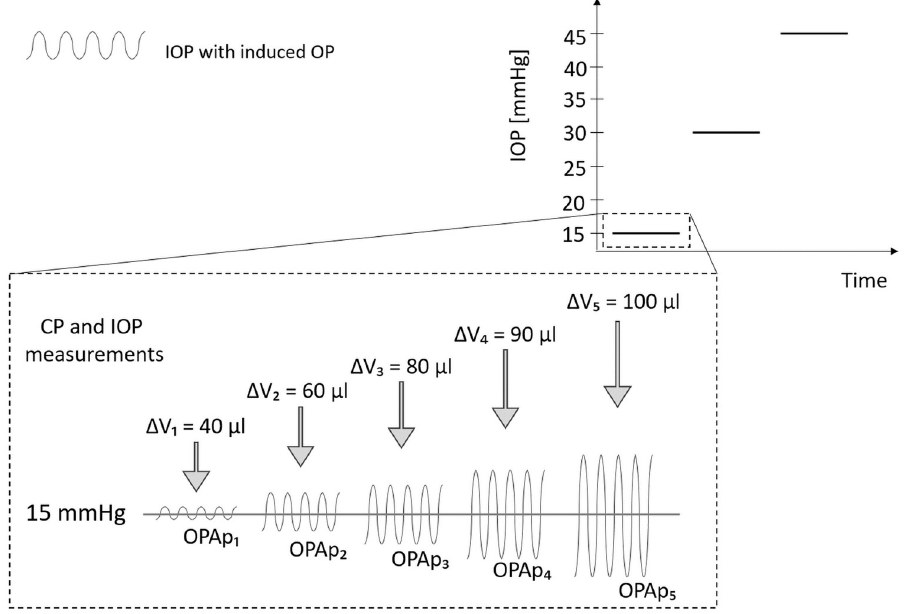
Fig 2. A scheme of the CP and IOP signal measurement procedure during ocular pulse (OP) simulations with controlled infusion/withdrawal PBS volume ( Δ V) in the three-step inflation experiment.